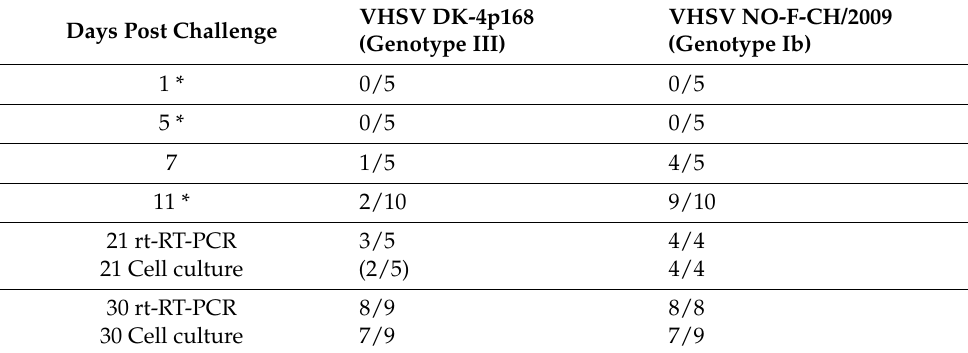
Table 1. Number of VHSV positive samples by rt-RT-PCR (and cell culture on day 21 and day 30) out of the number of examined Atlantic herring, Clupea harengus , challenged with VHSV genotype III DK-4p168 and VHSV genotype Ib NO-F-CH/2009, respectively. On days marked with an asterisk (*), only the gills were sampled, whereas on other days, internal organs as well as the gills were sampled. VHSV DK-4p168 VHSV NO-F-CH/2009 Days Post Challenge (Genotype III) (Genotype Ib) 1 * 0/5 0/5 5 * 0/5 0/5 7 1/5 4/5 11 * 2/10 9/10 21 rt-RT-PCR 3/5 4/4 21 Cell culture (2/5) 4/4 30 rt-RT-PCR 8/9 8/8 30 Cell culture 7/9